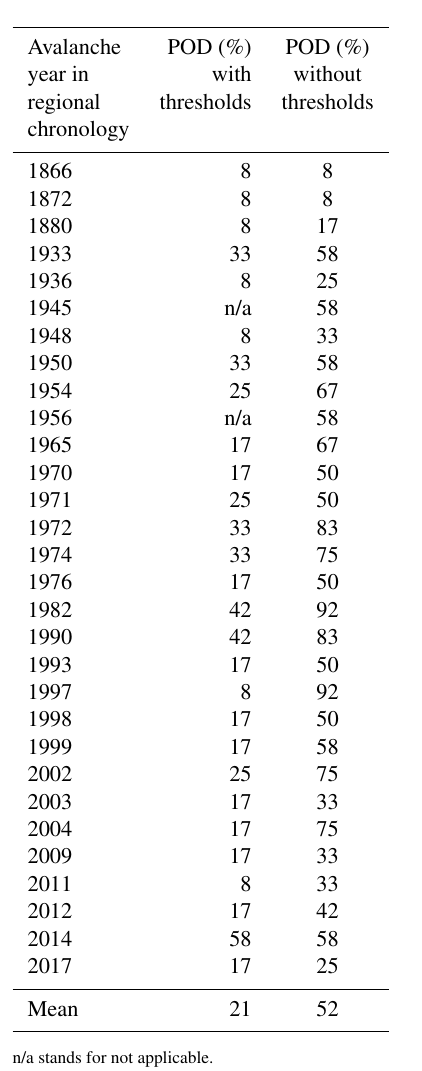
Table 7. Probability of detection (POD year ). Avalanche years iden- tified in the regional chronology and associated POD by analyzing individual paths with and without growth disturbances (GDs), sam- ple size, and W it thresholds.